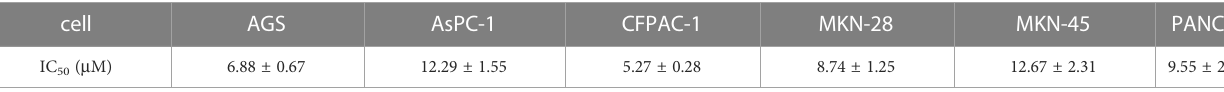
TABLE 1 IC 50 value of drugs on various tumor cells within 48 hours. cell